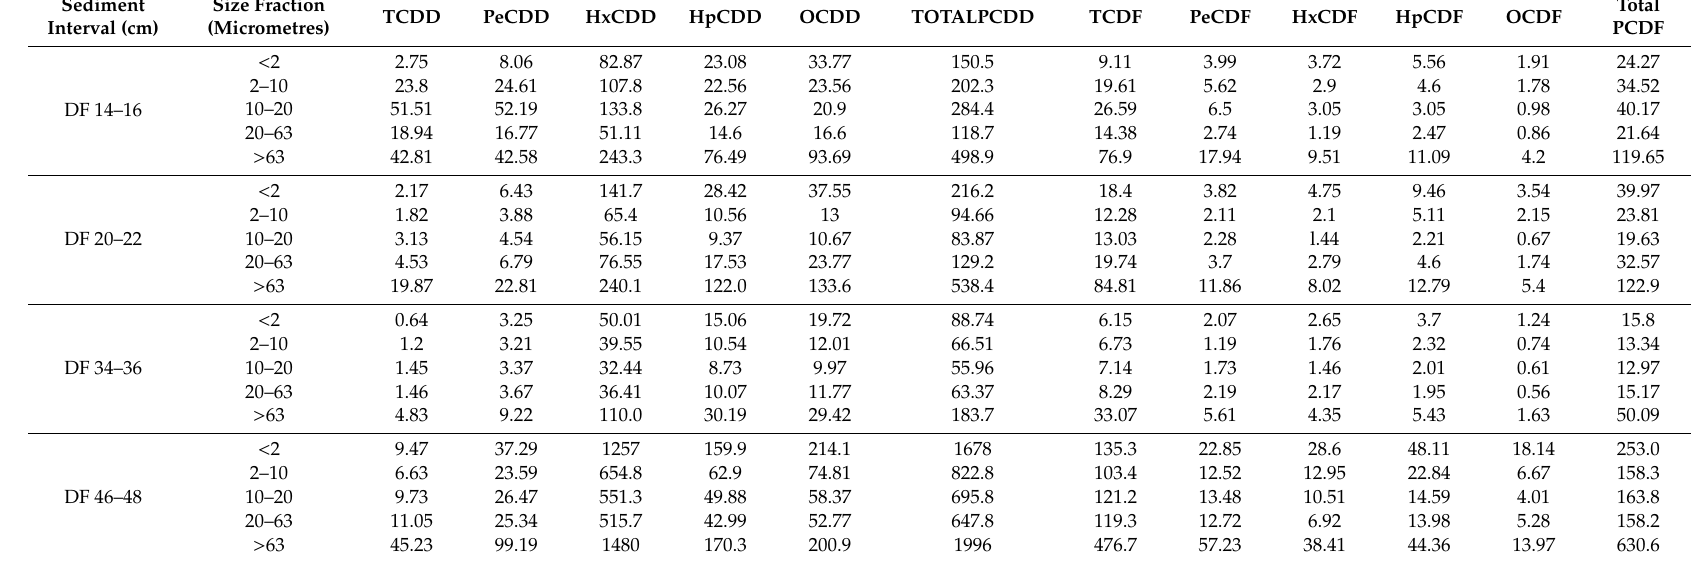
Table 6. Homologue and total homologue (PCDD, PCDF) concentration (pg / g) for dioxins and furans, in selected size fractionated sediment samples. Sediment Interval